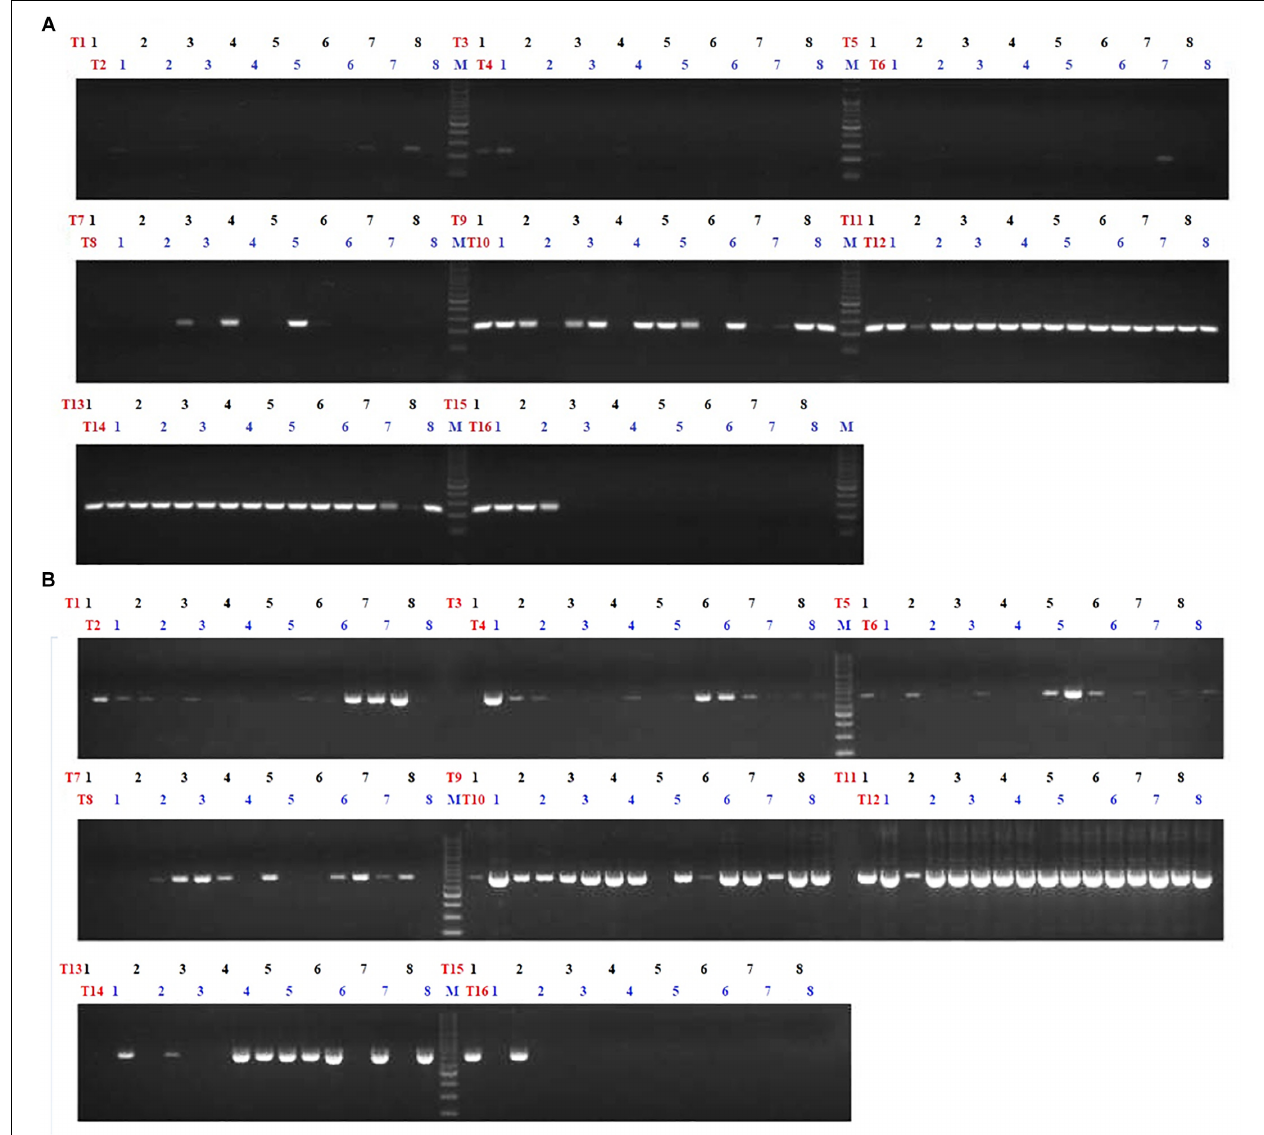
FIGURE 1 | Conventional PCR results using 2 primers ( XRE and cry 2) targeting 2 genes (transcriptional regulator and crystal protein genes) specific for B. thuringiensis with 120 strains. (A) Is the PCR results of the 120 strains using XRE and (B) is the PCR results using cry- 2. Lane M, 100 bp ladder; T1–T16 means the number of 8-strip tube and the details of each lane is shown in the Supplementary Table 1